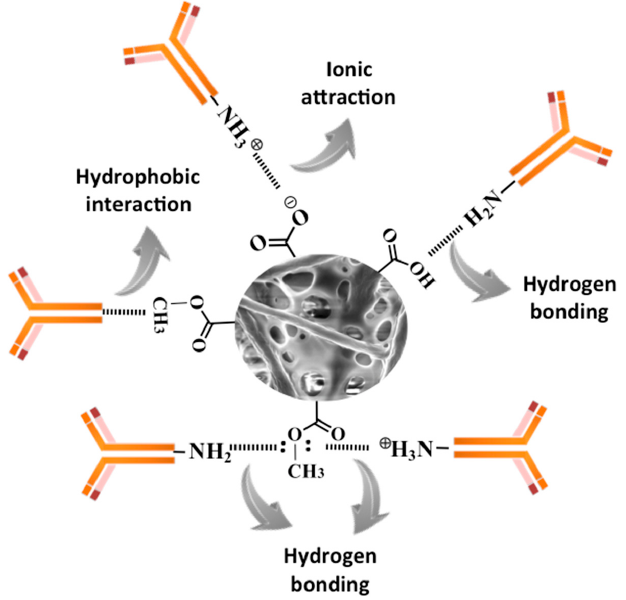
Table 1. Sensitivity, specificity, accuracy, and limit of detection (LoD) for coated and uncoated electrospun PHB